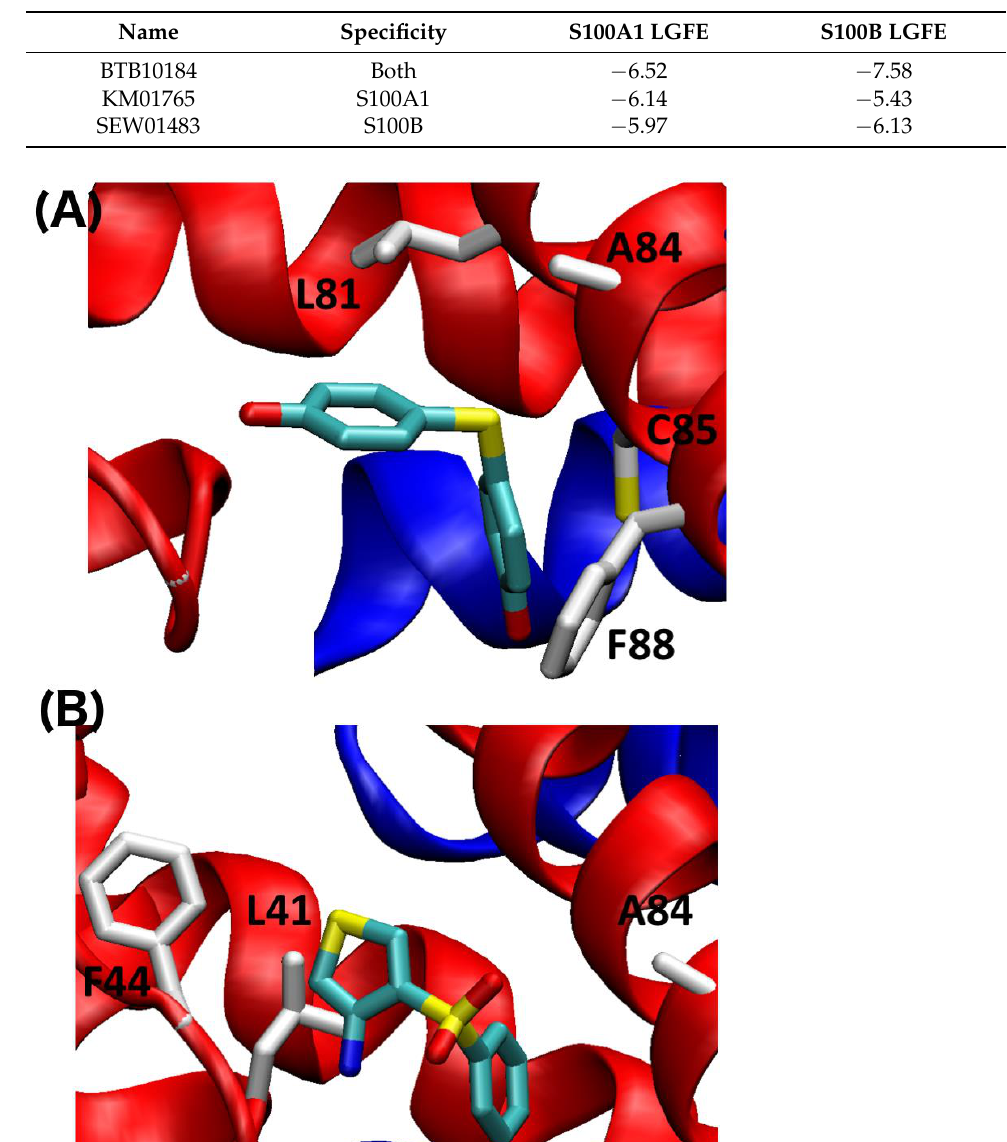
Figure 7. Predicted binding mode of ( A ) BTB10184 ( B ) KM01765 and ( C ) SEW01483 for Ca 2+ -S100A1. Residues in the pocket with large spectral perturbations are labeled. The two subunits of the S100 protein are colored in blue and red, respectively.